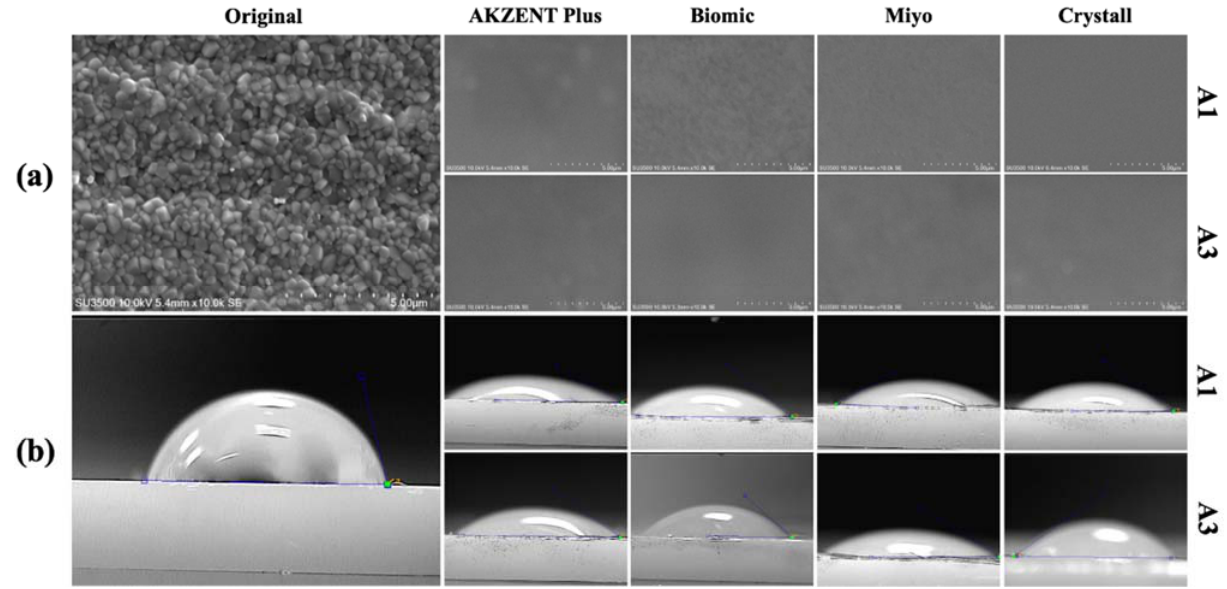
Figure 4. Surface modification of zirconia. ( a ) Microscopic image and ( b ) contact angle.